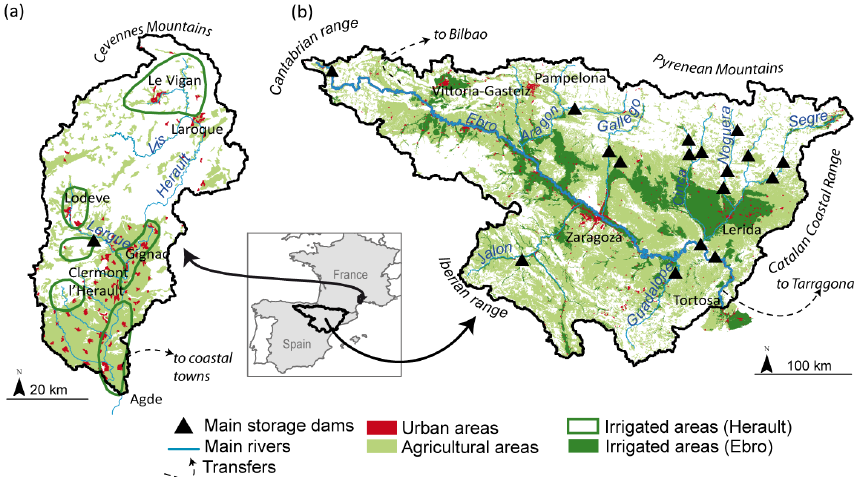
Figure 1. (a) The Hérault Basin (2500km 2 , France) and the (b) Ebro Basin (85000km 2 , Spain): location of the main human pressures on water resources (urban and agricultural areas, main storage dams and water